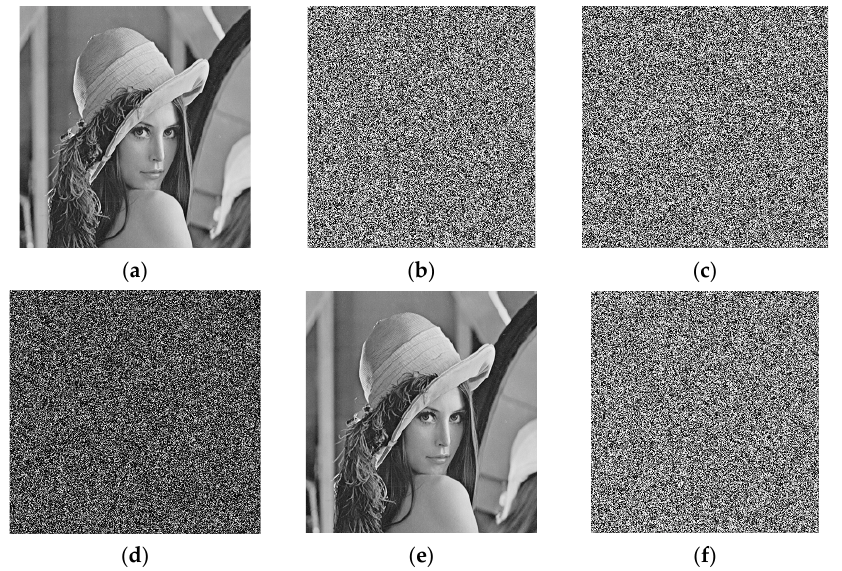
Figure 6. Key sensitivity analysis through various images: ( a ) Plain; ( b ) ciphered (E1); ( c ) ciphered (one-bit change in original key) (E2); ( d ) E1 XOR E2; ( e ) decrypted E1 with correct key; ( f ) decrypted E1 with an incorrect key.